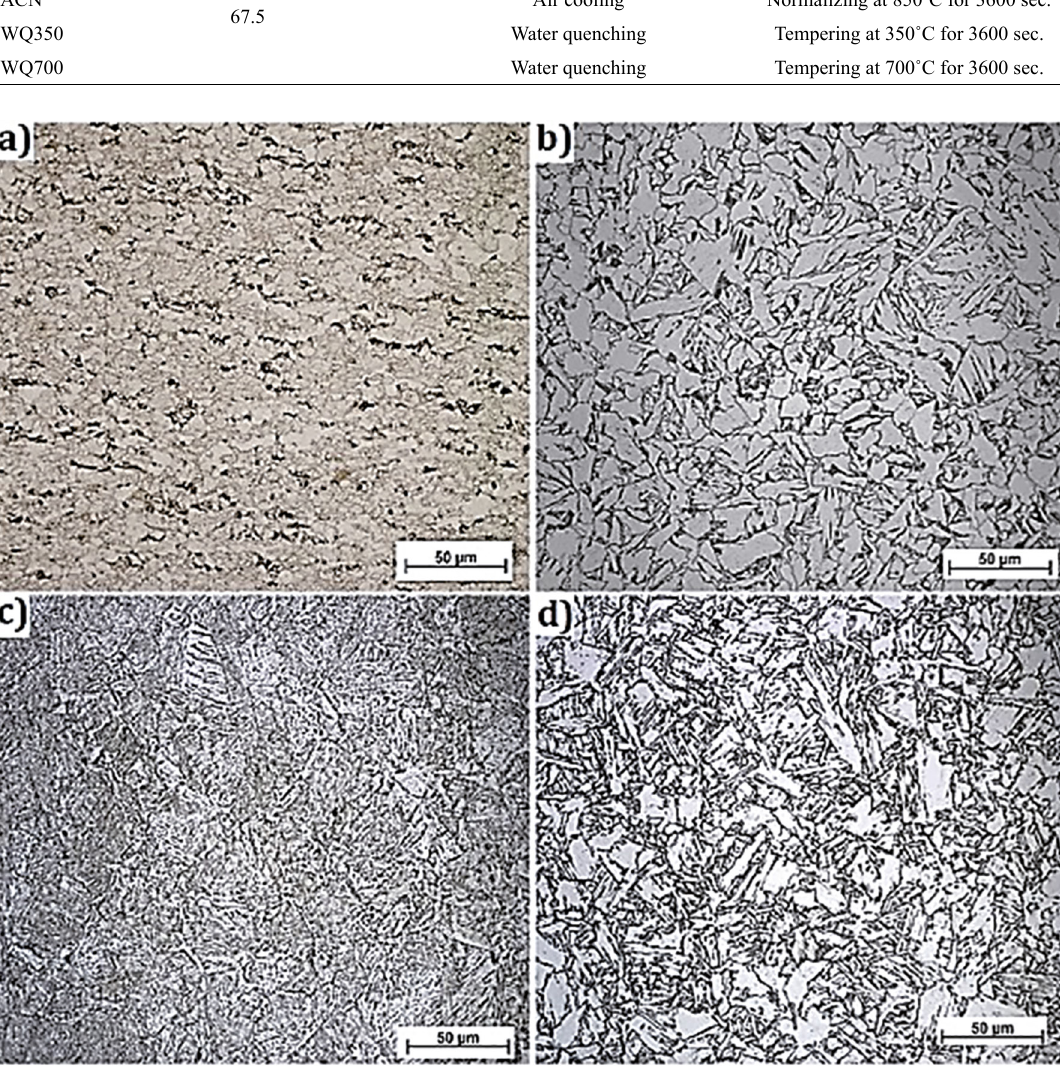
Figure 2: Optical micrograph of (a) AC, (b) ACN, (c) WQ350 and (d) WQ700